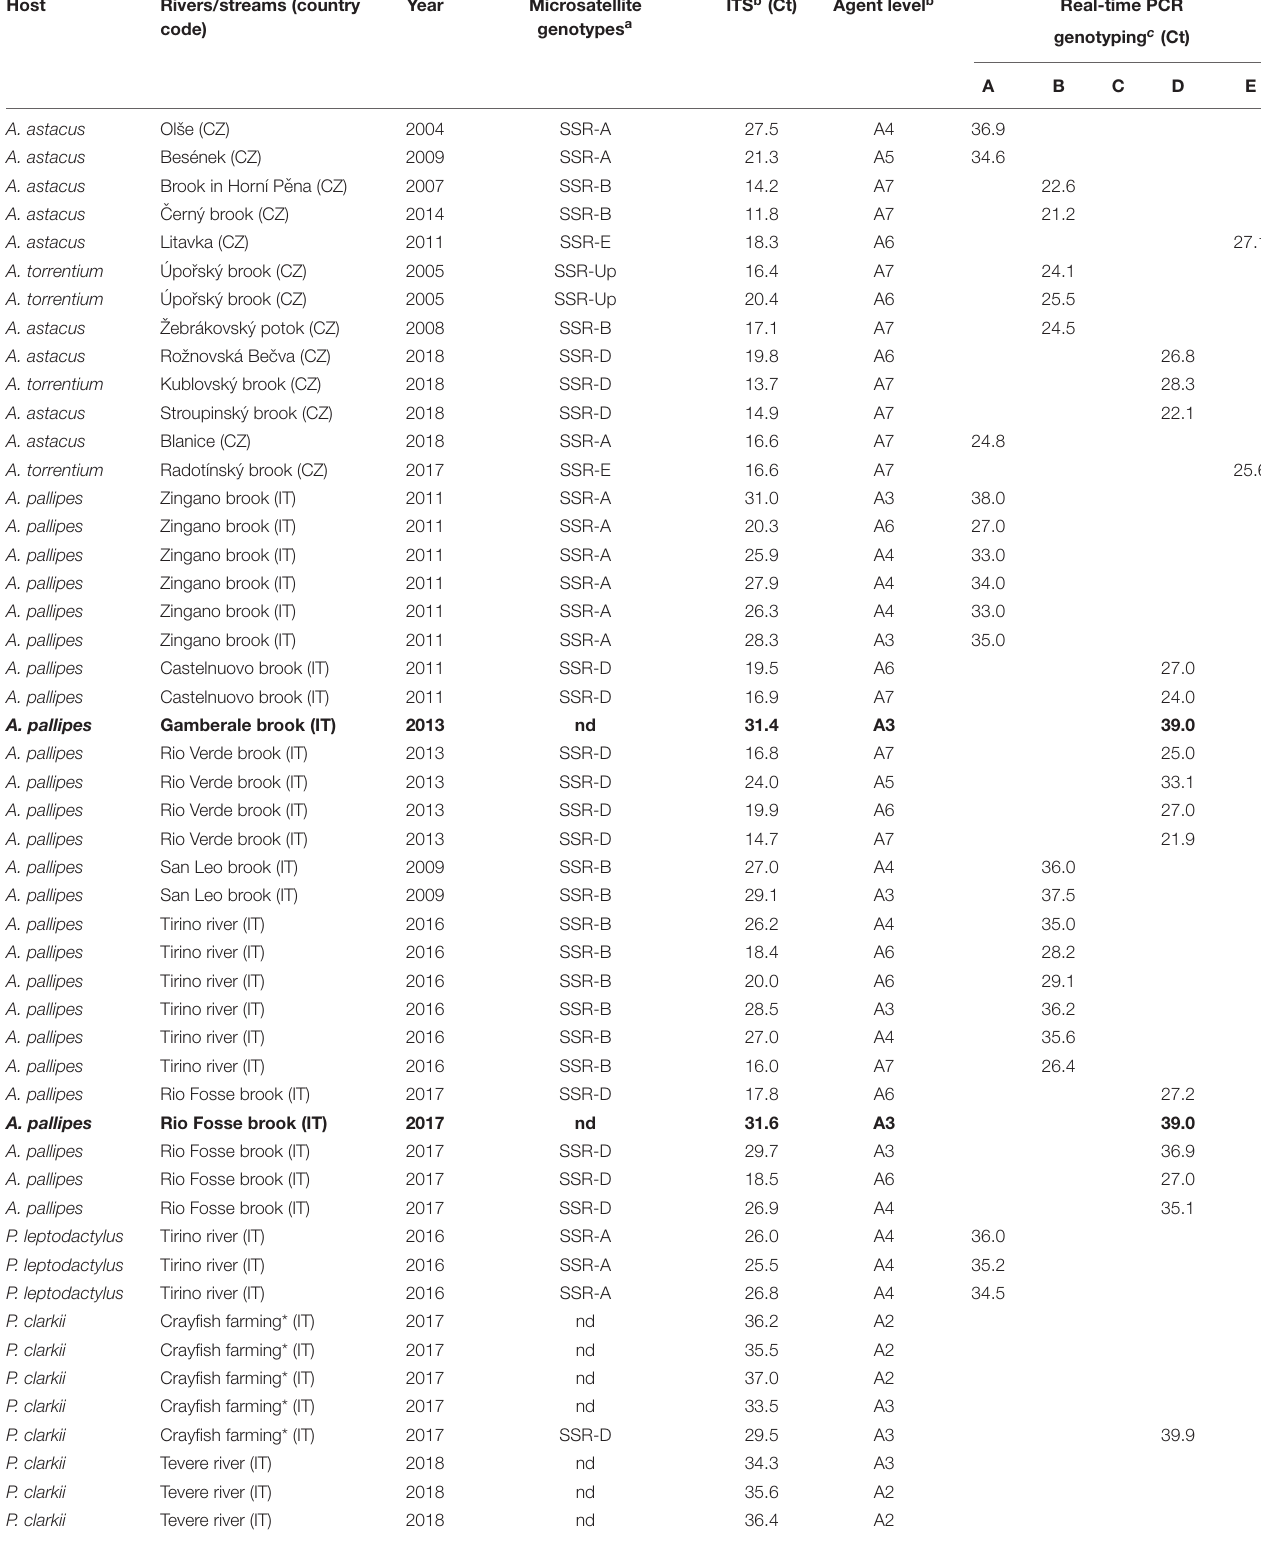
Year Microsatellite ITS b genotypes a